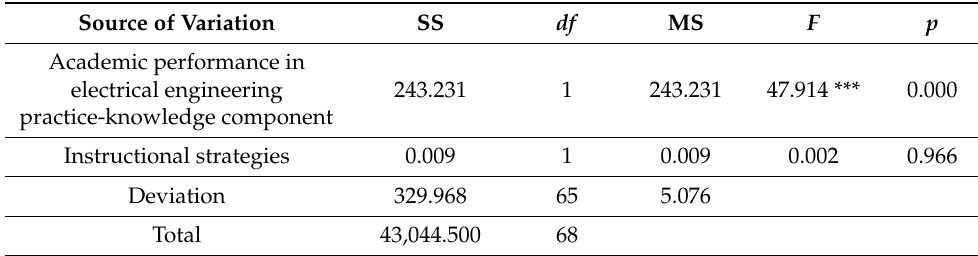
Table 13. Recapitulation sheet of analysis of covariance in basic electricity practical overall learn- ing effectiveness.